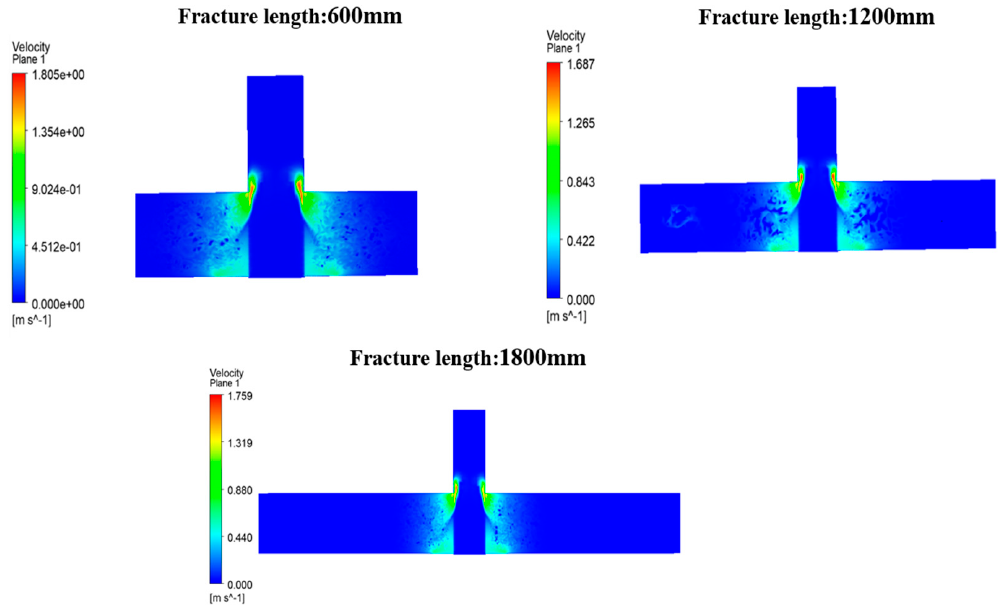
Figure 18. Velocity distribution at different fracture lengths in 0.5 s.